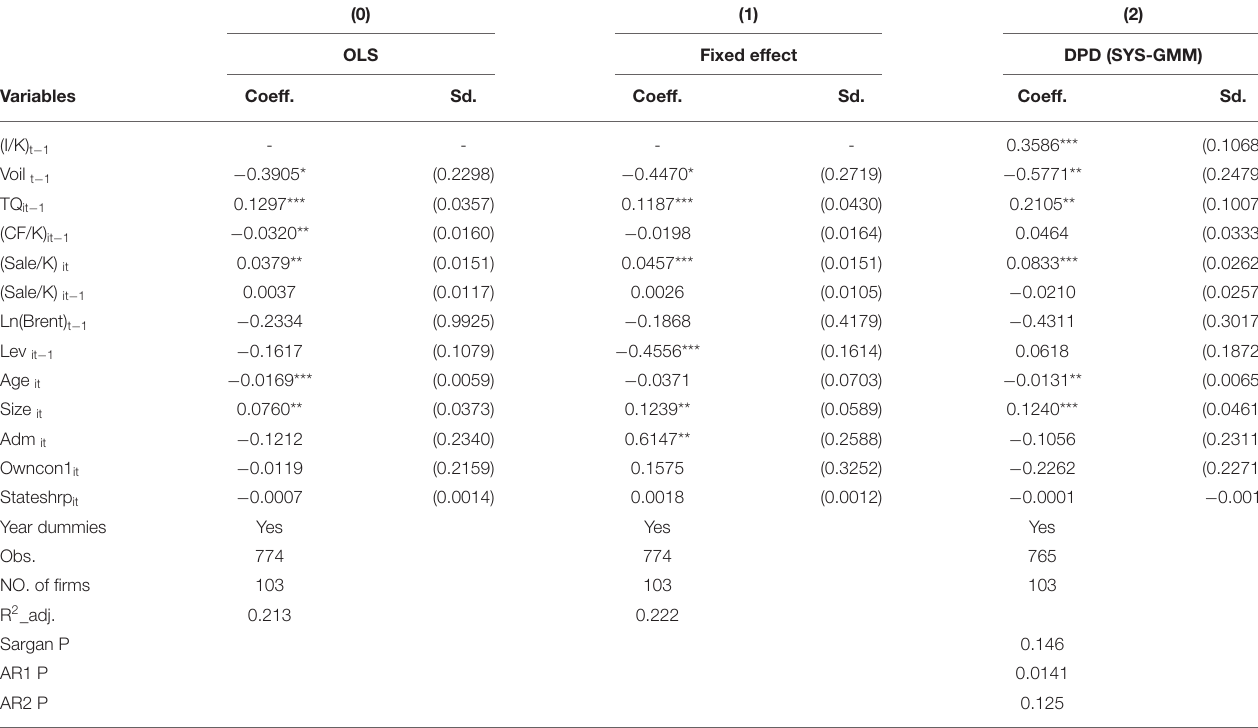
TABLE 2 | The impact of oil price volatility on